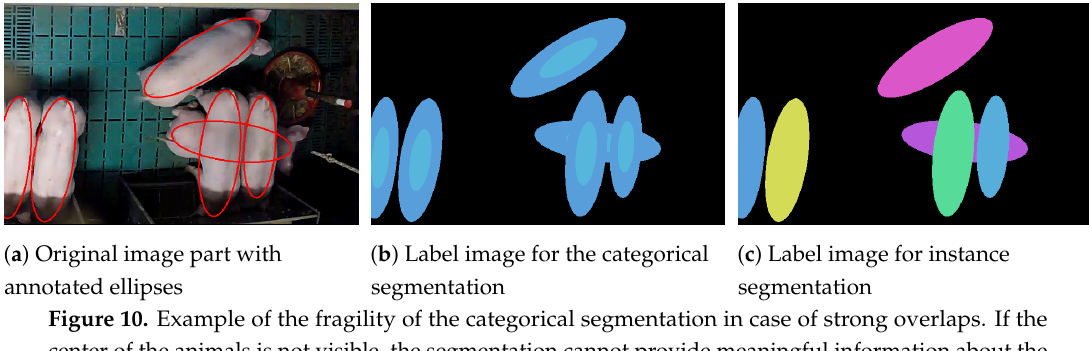
Figure 10. Example of the fragility of the categorical segmentation in case of strong overlaps. If the center of the animals is not visible, the segmentation cannot provide meaningful information about the hidden animal ( b ). The instance segmentation, on the other hand, does not have this problem ( c